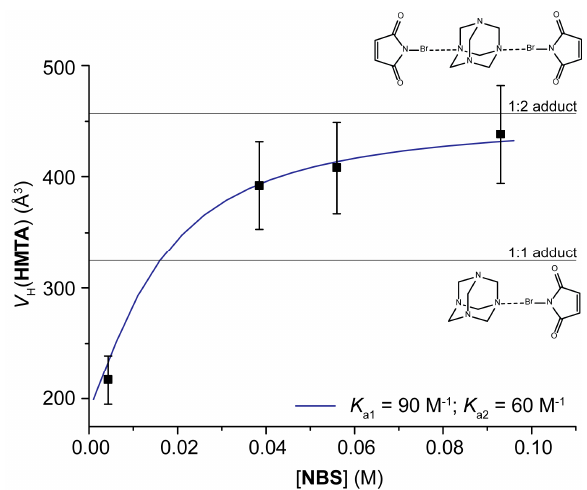
Figure 10. Adapted with permission from reference [107]. Experimental hydrodynamic volume of HMTA (C = 2.1 mM) at different concentrations of NBS . The solid line represents the best fitting equation for the 1:2 model. Copyright 2016 The Royal Society of Chemistry.